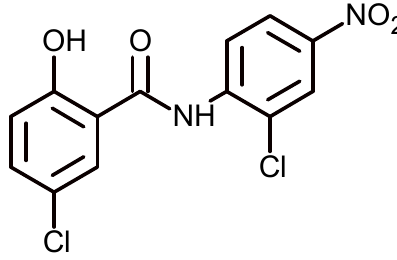
Figure 10. Niclosamide structure, an anthelmintic drug used to treat parasitic infections.